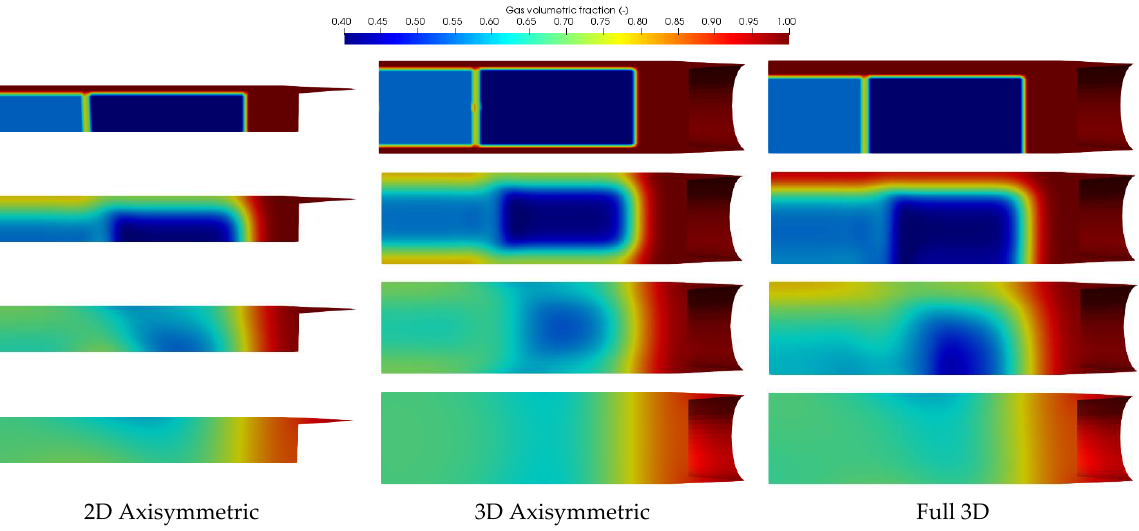
Figure 3. Numerical results for the M4A2 firing simulation. Comparison of the fields of gas volumetric fraction for 2D Axisymmetric, 3D Axisymmetric, and Full 3D. From top to bottom: 𝑡 = 0, 0.25, 1.00, and 4.00 ms.